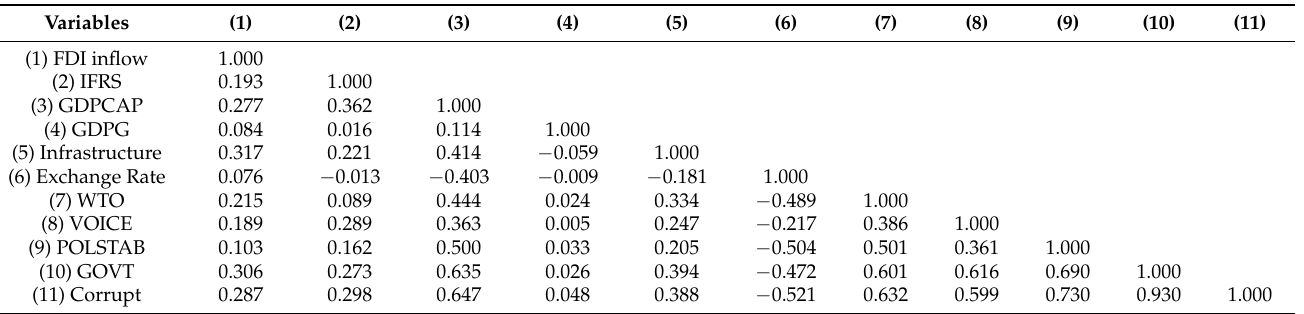
Table A3. Pairwise Pearson correlations.